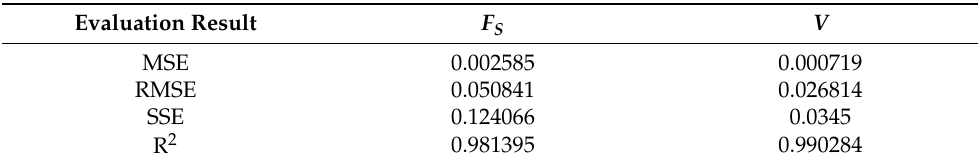
Table 5. LSSVM model accuracy evaluation results.